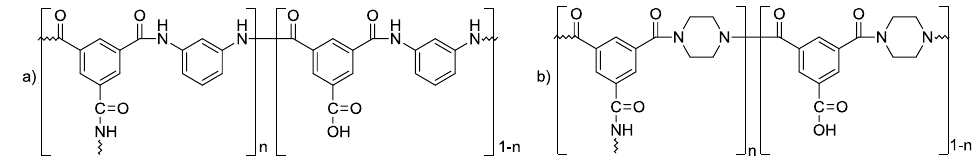
Figure 9. Structures of the active polyamide layer of BW30 ( a ) and NF270 ( b ). The value n denotes the